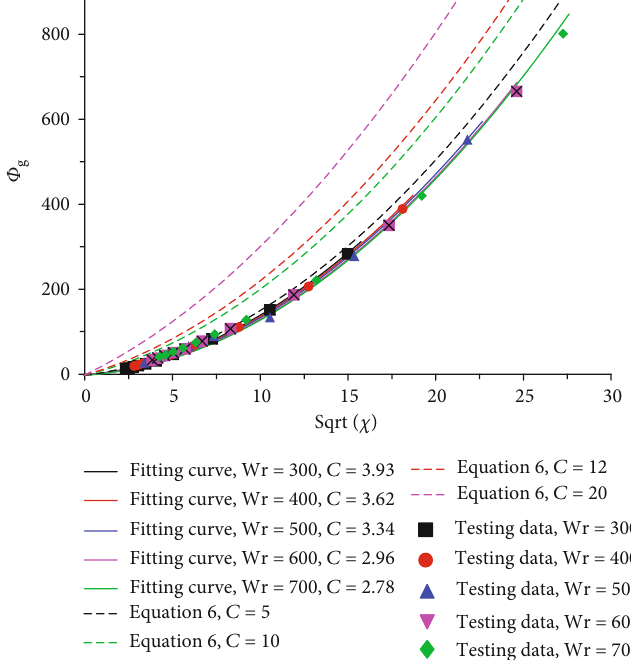
Figure 14: The relationship between Φ